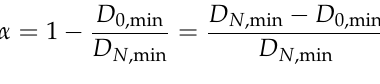
D ( b ) D . Figure 9. Changes of D min max